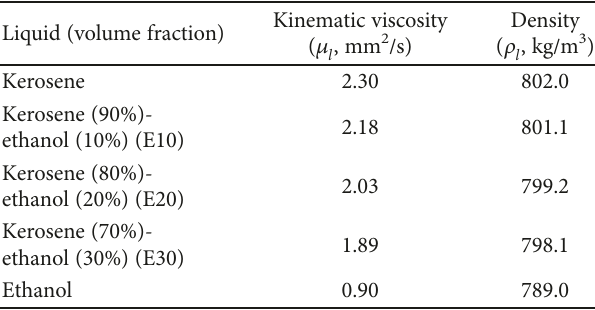
Figure 3: Experimental setup for spray visualization and droplet sizing. Table 1: Fuel properties.